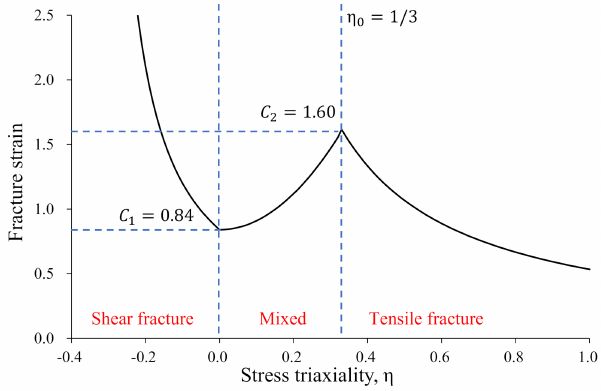
Figure 8. Locus of the calibrated fracture